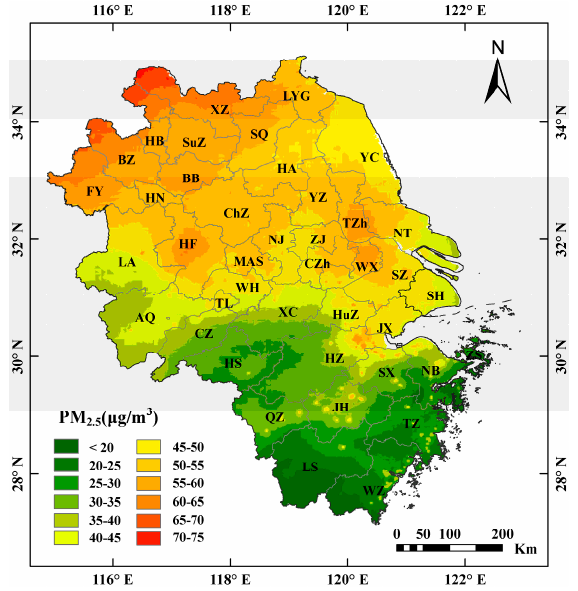
Figure 2. The 16-year mean PM 2.5 values in the YRD from 2002 to 2017.